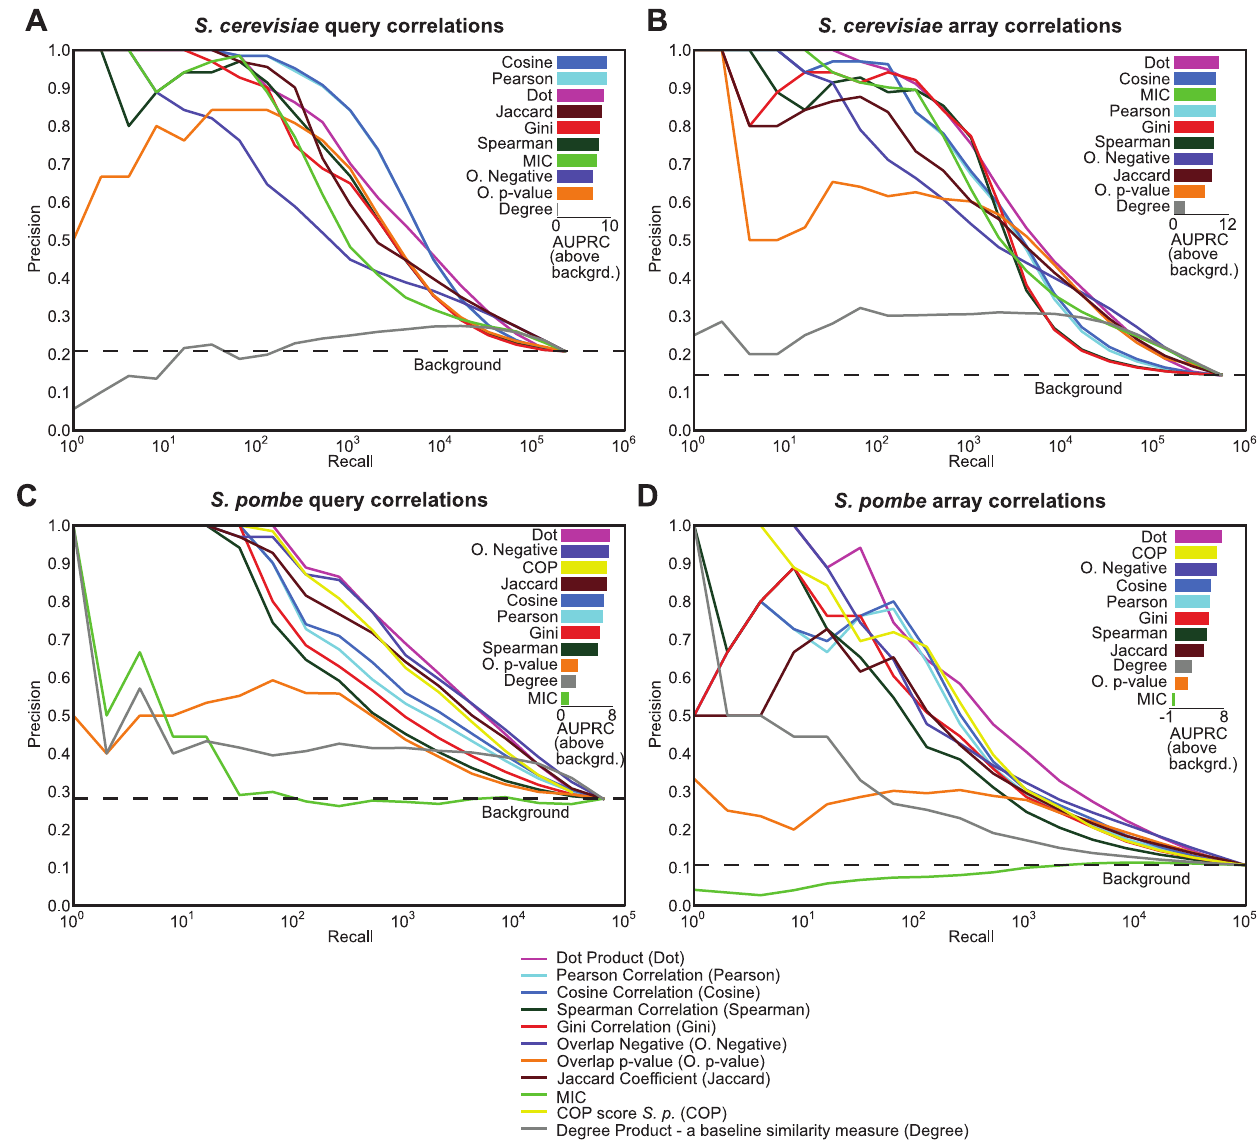
Figure 1. Comparison of similarity measures applied to genetic interaction datasets. Gene pair correlations derived from each similarity measure were benchmarked against a Gene Ontology-based standard using precision-recall statistics. The comparison was conducted on (A) S. cerevisiae genetic interaction data (Costanzo et al. 2010) - query genes’ similarities, (B) S. cerevisiae genetic interaction data - array genes’ similarities, (C) S. pombe genetic interaction data (Ryan et al. 2012) - query genes’ similarities, and (D) S. pombe genetic interaction data – array genes’ similarities. The horizontal dotted line shows the background precision expected from randomized ranking of gene pairs. The bar plot on the upper right corner in each section shows the area under the precision-recall curve (AUPRC) above the background for each similarity measure. The area was calculated by summation of the areas of trapezoids at increments of 2 n (log 2 units). The bars are sorted by their respective areas above background.